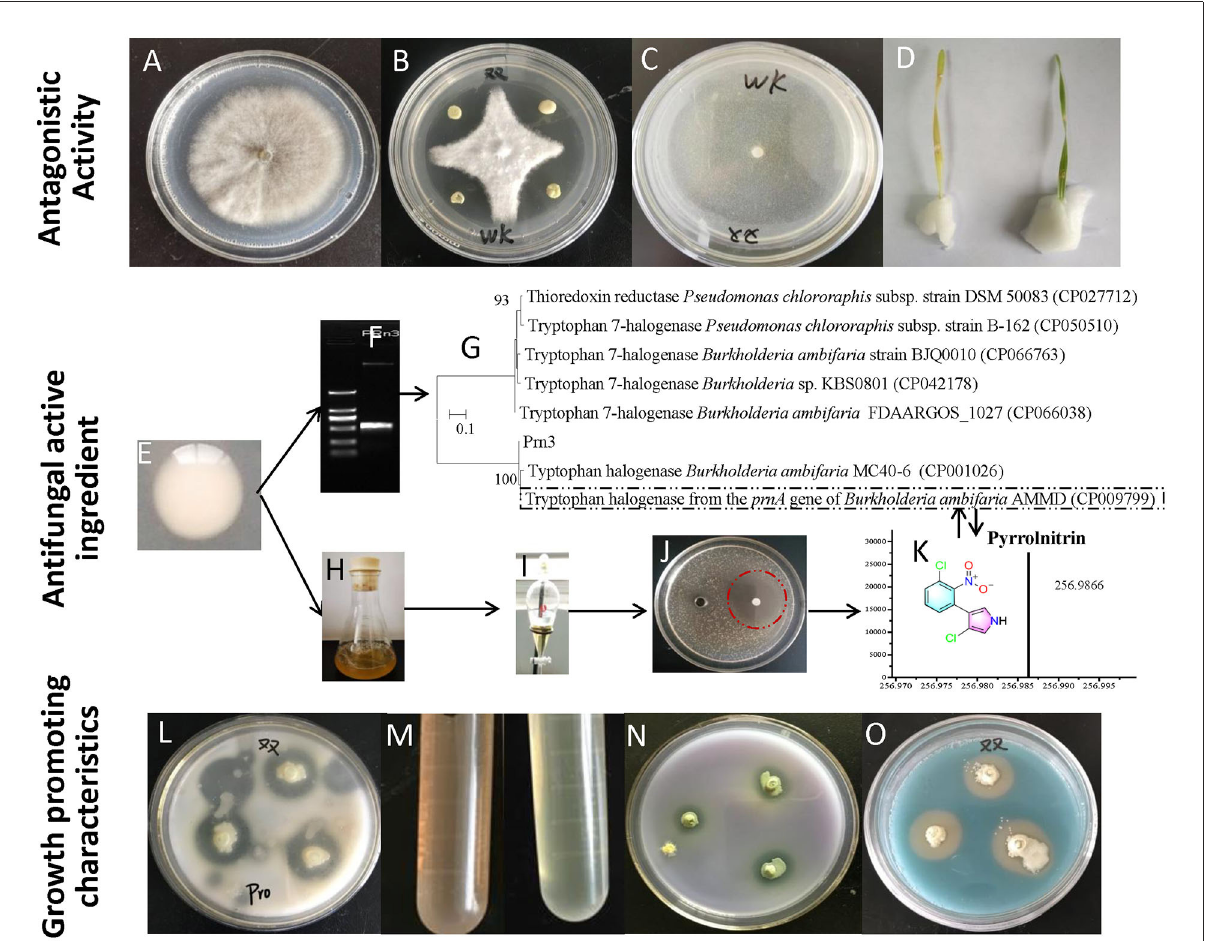
FIGURE2 Antagonistic activities and plant growth-promoting characteristics of the strain XN08. R. cerealis grown on PDA medium (A) , in vitro antagonism of B. ambifaria XN08 against R. cerealis (B) , R. cerealis grown on PDA medium supplemented with the fermentation broth supernatant of B. ambifaria XN08 (C) , inhibition of the fermentation broth supernatant of the strain XN08 against R. cerealis on detached leaves of wheat plants (D) , amplification and sequence comparison of the antibiotic synthesis genes (E–G) , fermentation of the strain XN08 (H) , extraction of antifungal compounds (I) , detection of antifungal activities (J) , identification of antifungal compounds by UPLC-QTOF-MS method (K) , and plant growth-promoting traits of B. ambifaria XN08 in vitro [ (L) , proteinase production; (M) , IAA production; (N) , the capacity of phosphate solubilization; (O) , siderophore